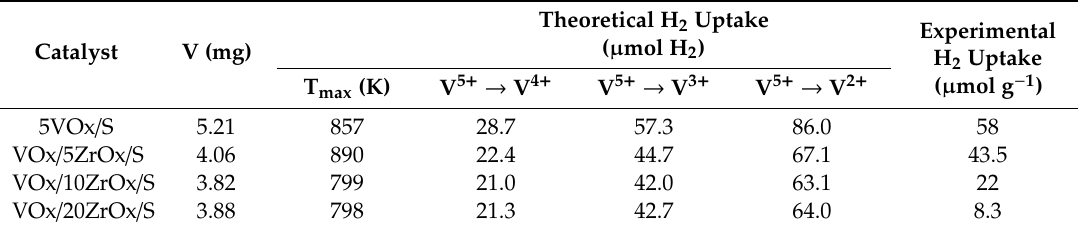
Figure 7. TPR profile of various VOx / yZrOx / S catalysts: ( a ) 5VOx / S, ( b ) VOx / 5ZrOx / S, ( c ) VOx / 10ZrOx / S, and ( d ) VOx / 20ZrOx / S. Table 2. Comparison of TPR results for VOx on di ff erent supports and the theoretical and experimental H 2 consumption. T max corresponds to the temperature of maximum H 2 consumption.